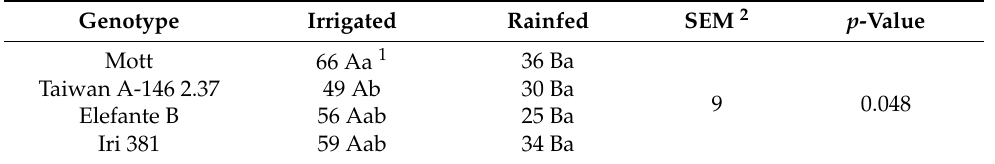
Table 2. Leaf accumulation rate (LAR; kg dry matter/ha per day) as affected by the interaction between genotype and irrigation for elephantgrass genotypes at Garanhuns, Pernambuco, Brazil.